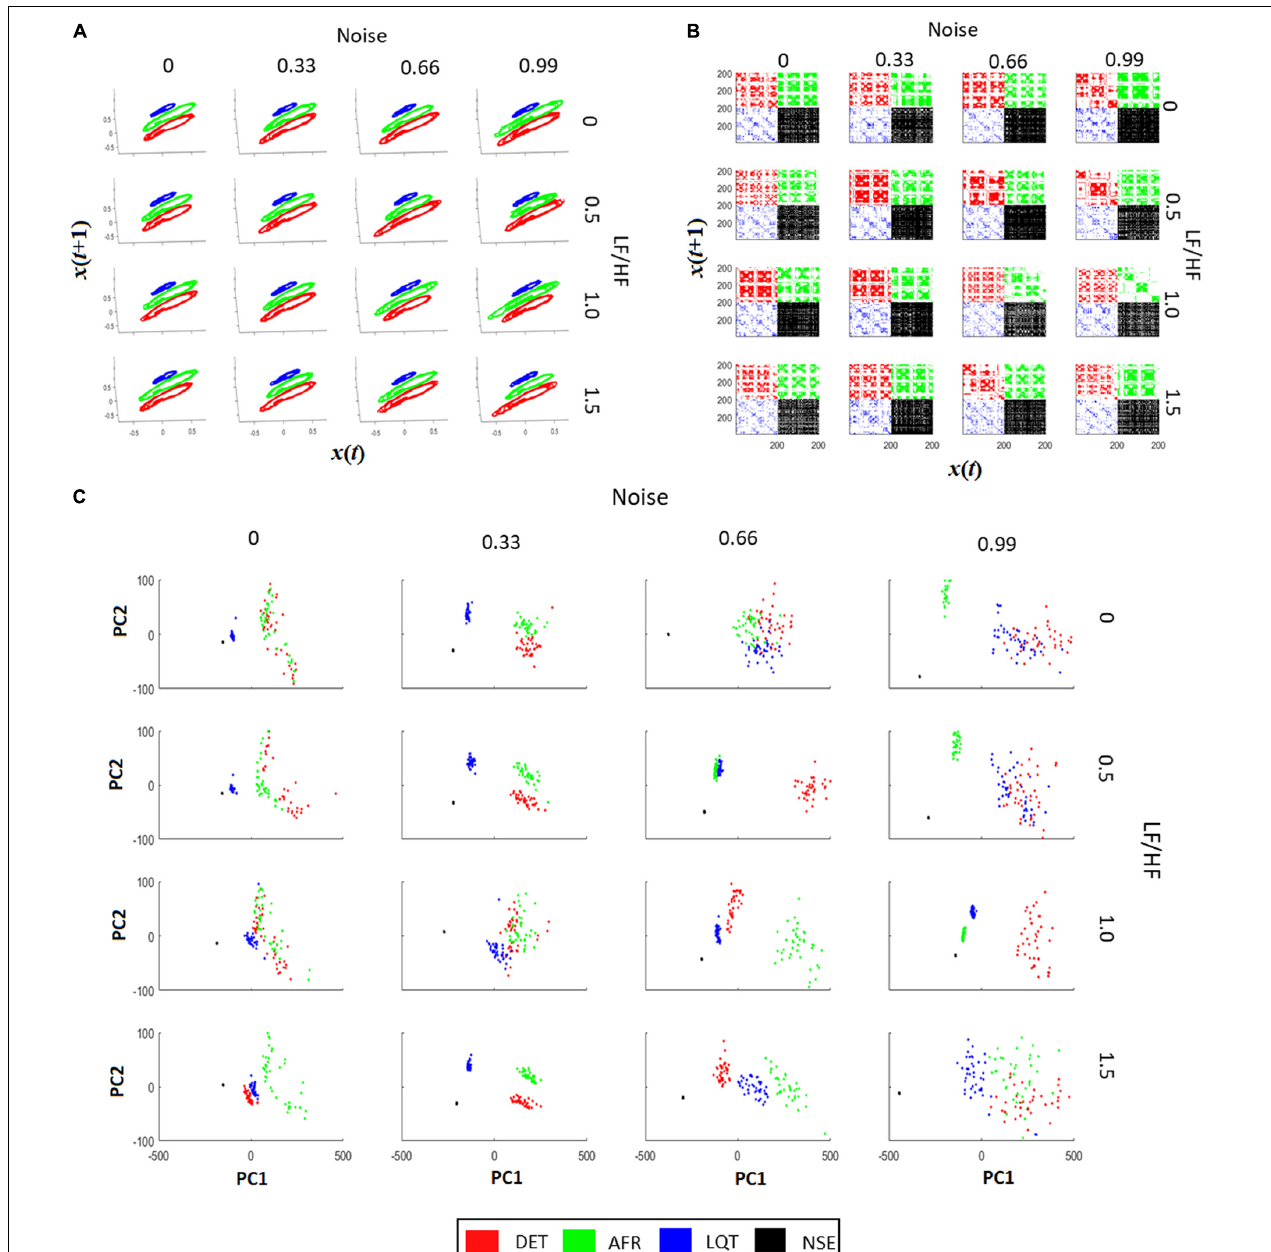
FIGURE 5 | Recurrence quantification analysis (RQA) characteristics of aECG signals. (A) The signal recurrences of each group in each condition. Higher values of LF/HF increase the variability of ECG in the phase-space trajectories. (B) Each recurrent plot (RP) of each group are different. The changes happen not only on individual dots, but also on the dot-lines and diagonal dot-structures, changing the main characteristics gather from RPs. By increasing the intensity of noise in the tachograms, it turns the RP pattern less periodic, affecting the main structures related to trajectory recurrences in RPs. The LF/HF modulation turns the dot-structures less regular, also affecting the value of dot-structures related to recurrences. (C) PCA projections using RQA coefficients (RR, DTM, < D > , Vmax, ENT, TT, T2) for each aECG condition. In most cases it is possible to differentiate each cluster from each group. The raise of LF/HF modulation changes the clusters from Long QT syndrome (LQT) and atrial fibrillation (AF), and the raise of noise, let the RQA features less condensed, making it more difficult to differentiate AF from